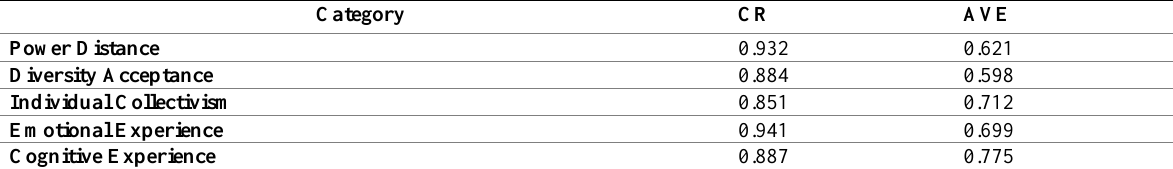
Table 3: Constructs’ reliability and convergent validity